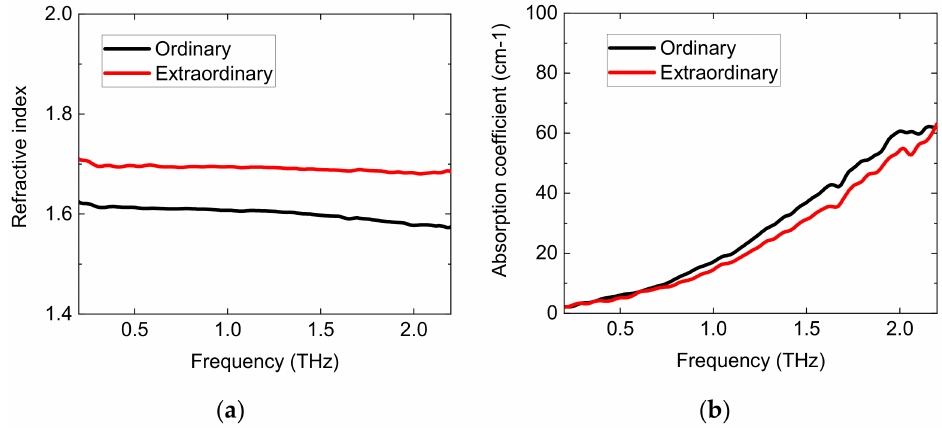
Figure 2. ( a ) Refractive index and ( b ) absorption coefficient of liquid crystal polymer